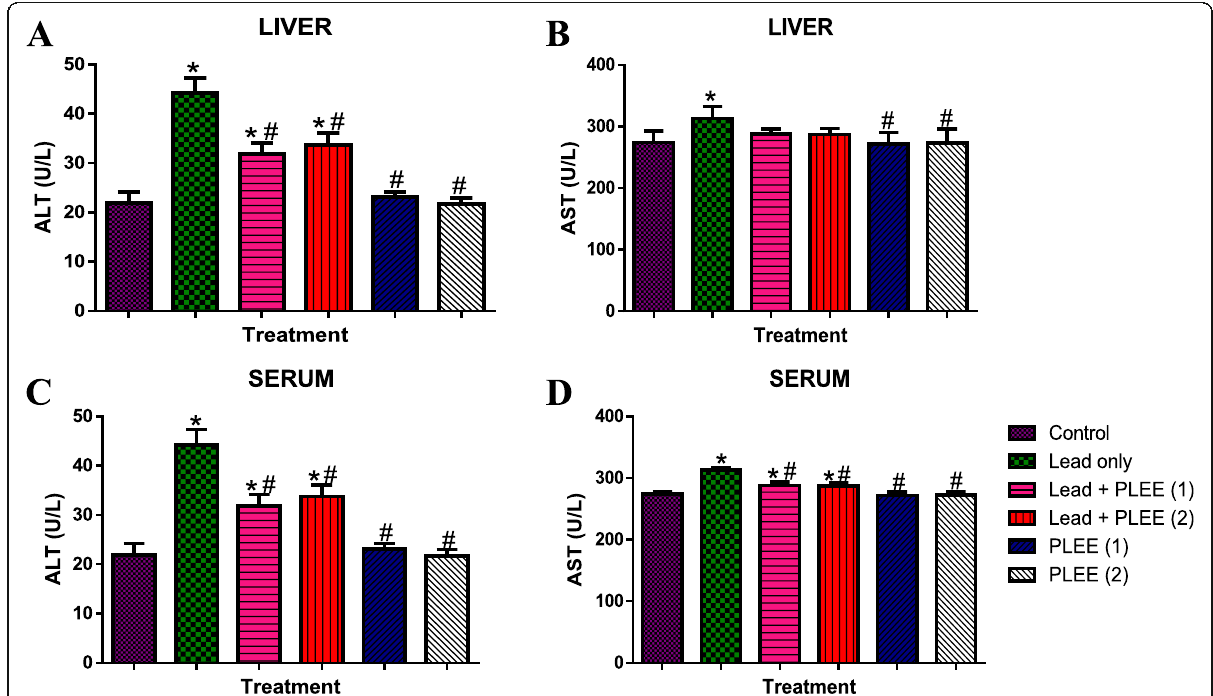
Fig. 1 Changes in the levels of ALT and AST in hepatorenal toxicity induced with lead acetate and treated with PLEE in Wistar rats. A: ALT liver B: AST liver C: ALT serum D: AST serum. Results are represented as mean ± SD ( n = 5). *- Significantly different from the negative control group, #- significantly different from Lead-only group ( p <